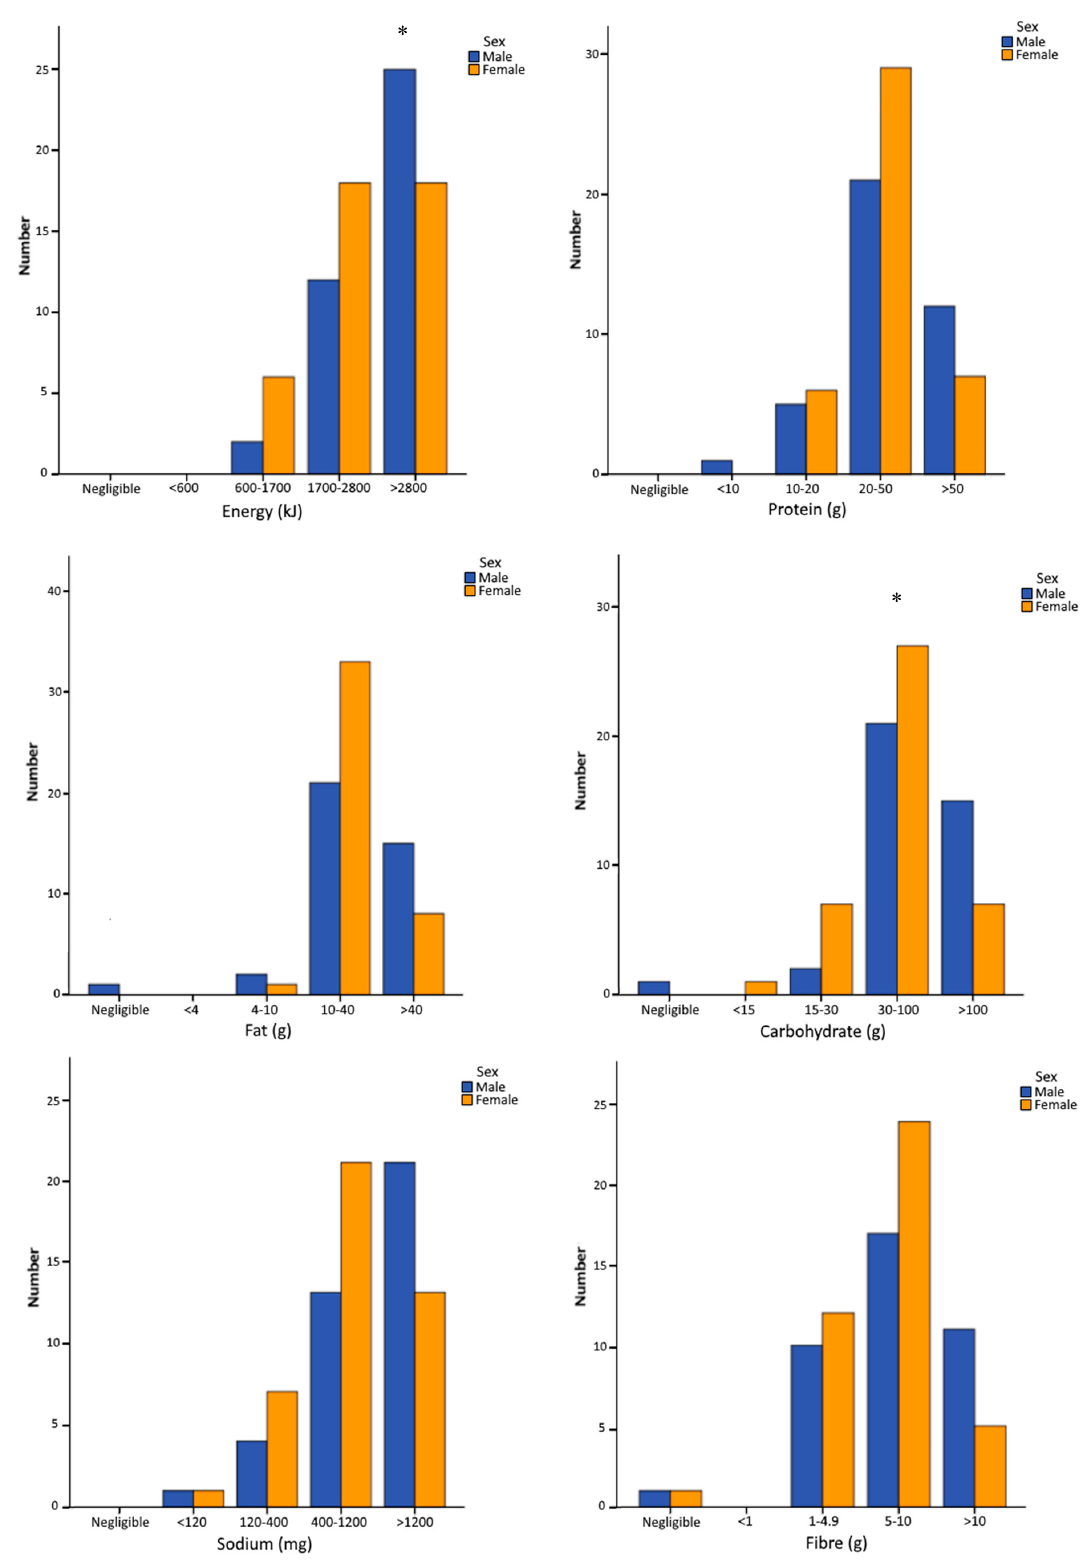
Figure 1. Energy and nutrient content of participants’ meal grouped into categories of negligible, low, medium, high and very high (* Mann–Whitney U test—significant difference between sexes for energy (627.0; p < 0.042) and carbohydrate (600.0; p = 0.018)).